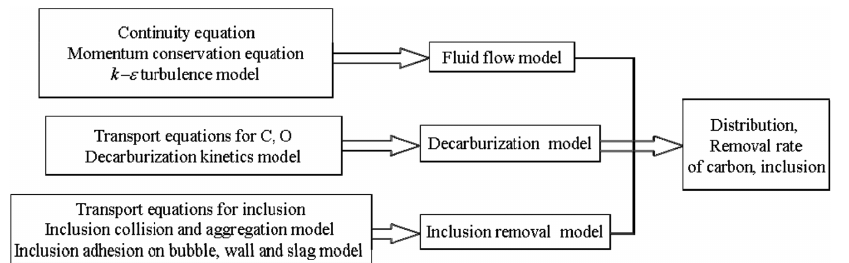
Figure 2: Schematic diagram of present